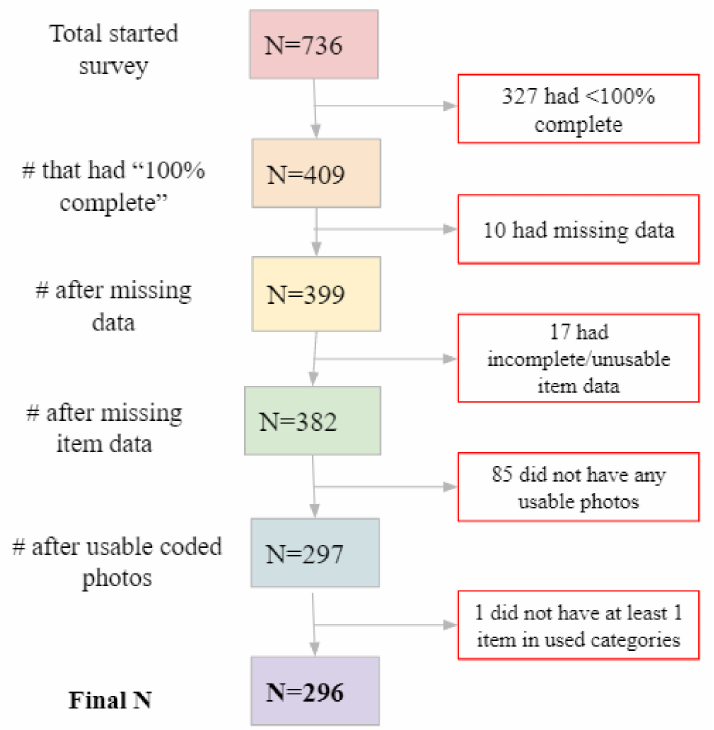
Figure 2. Flow chart with the number of subjects who started the survey and the final number analyzed after excluding missing and incomplete data.